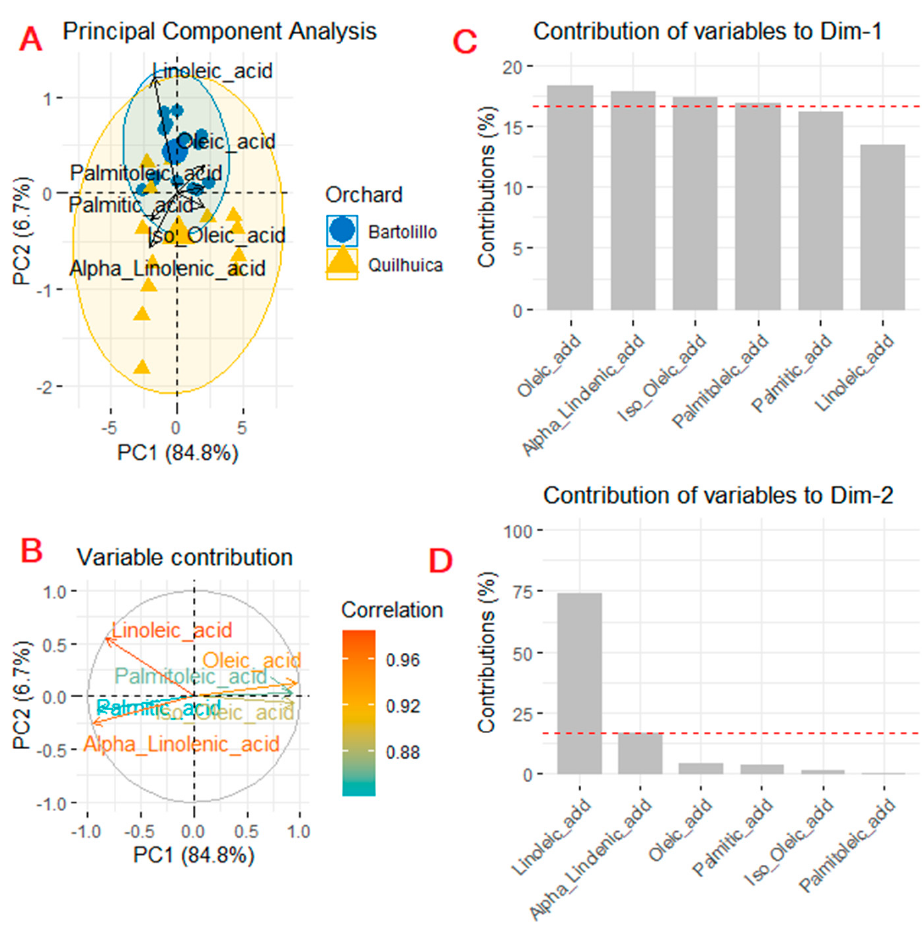
Figure 3. Principal component analysis ( A ), the loadings ( B ), and variable contributions to each component ( C , D ).